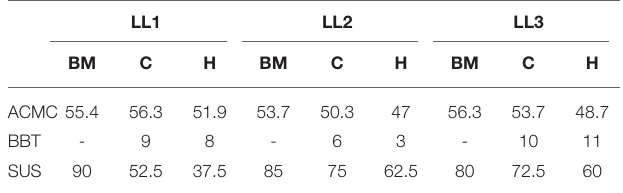
TABLE 5 | Limb-intact subject results. TABLE 6 | Limb loss subject